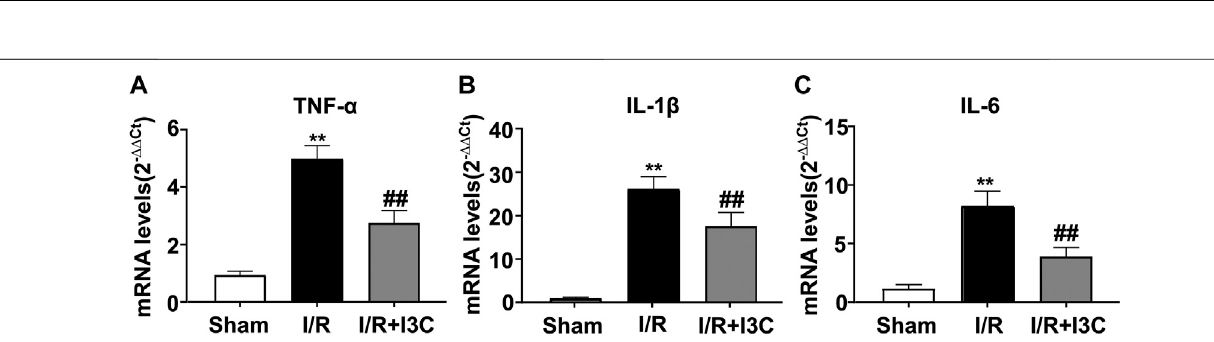
FIGURE 5 | Effect of I3C on in fl ammatory parameters in myocardial tissue of I/R mice. (A – C) Quantitative analysis showed that I3C pretreatment (100 mg/kg) prevented the I/R-induced increase in the expression levels of TNF- α (A) , IL-1 β (B) , and IL-6 (C) in ischemic cardiac tissue ( n = 8, ** p < 0.01 vs. sham treatment, ## p < 0.01 vs. I/R). Data are expressed as mean ±